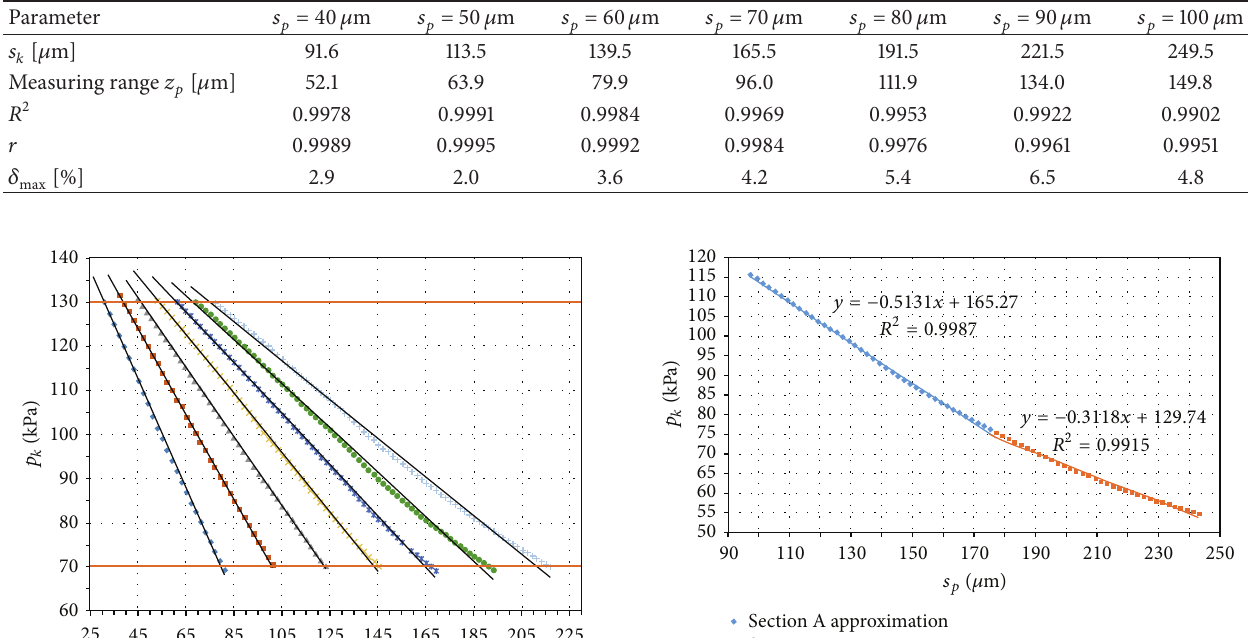
Table 1: Results of the calibration.